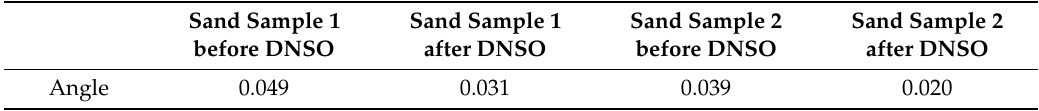
Table 3. Spectral angle mapper (SAM) angles between sand sample measurements on the ground and the corresponding airborne image pixels before and after applying the DNSO algorithm; the best angle is in bold.